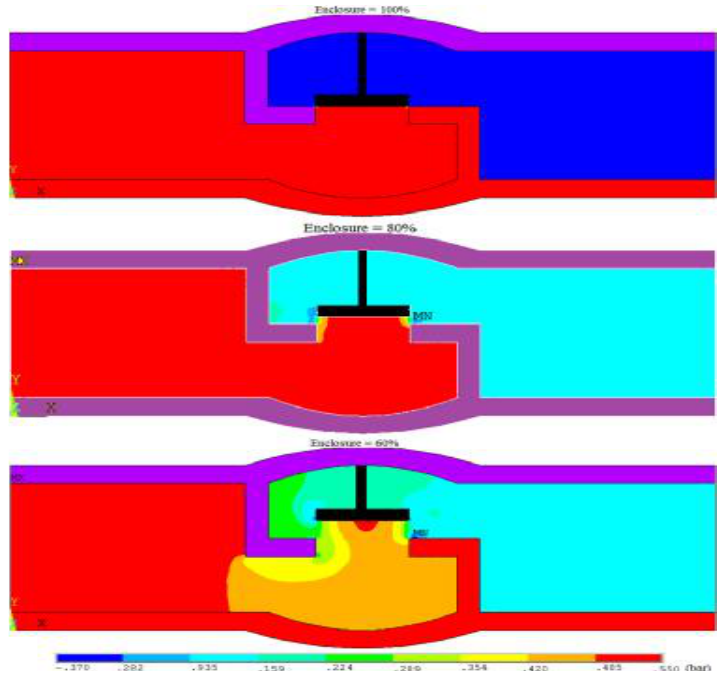
Fig. 6. Pressure distribution over the flow domain of globe valve at different enclosure